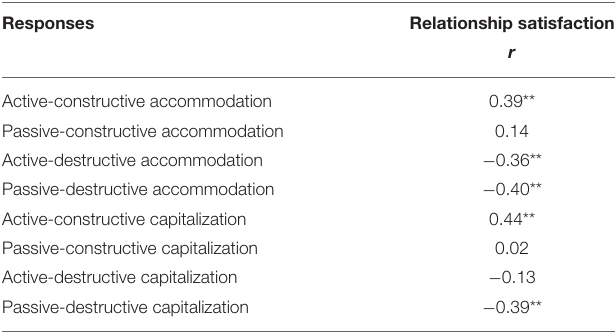
TABLE 3 | Correlations for accommodation and capitalization responses with relationship